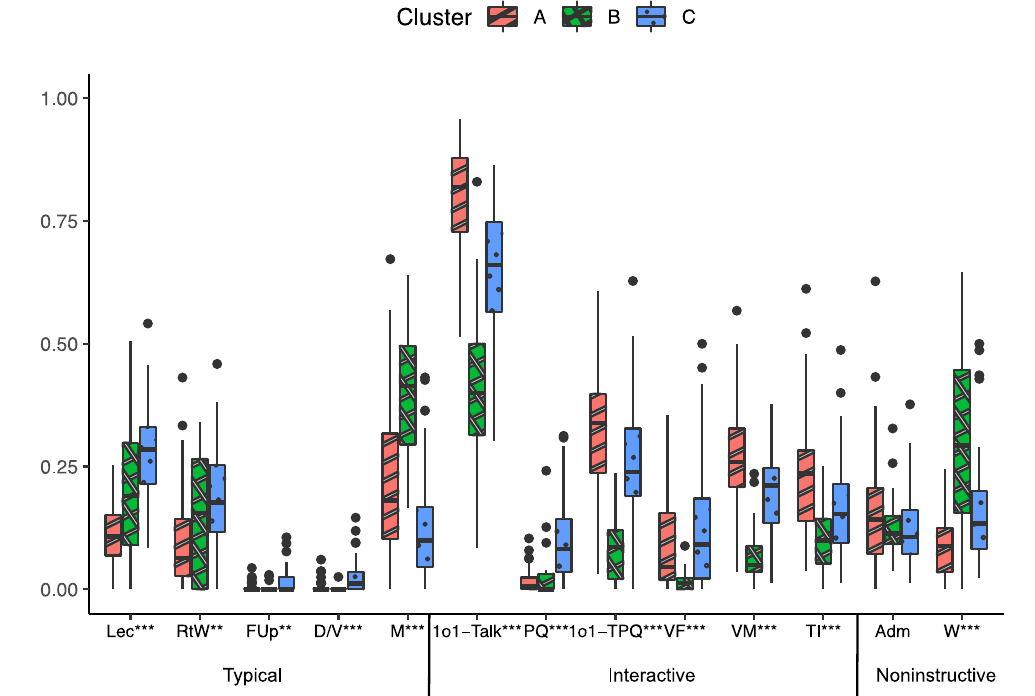
FIG. 4. Fraction of 2-min intervals per class period for each GTA code in each cluster. Out of 13 GTA codes, 12 codes are statistically significant between clusters. **medium effect size, ***large effect